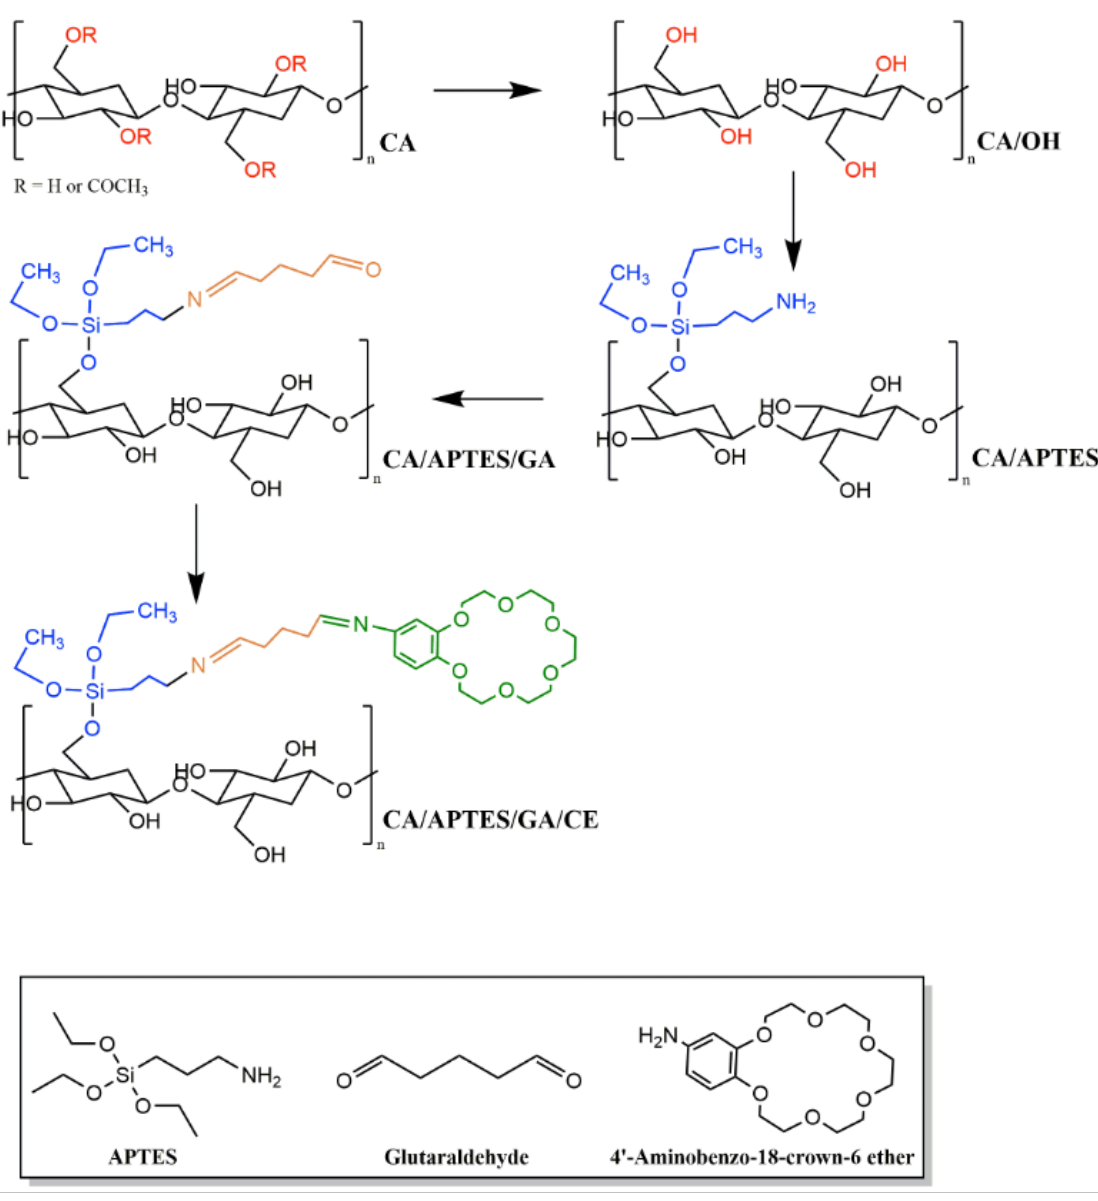
Figure 1. Reaction scheme for immobilization of crown ether on cellulose acetate membranes. For Fourier transform infrared spectroscopy analyses (FT-IR), we used Bruker Vertex 70 (Bruker, Billerica, MA, USA) equipment, with a diamond ATR device in the range of 600–4000 cm − 1 . After 32 successive measurements, an average spectra result was reported, eliminating noise, atmospheric CO 2 , and atmospheric moisture.